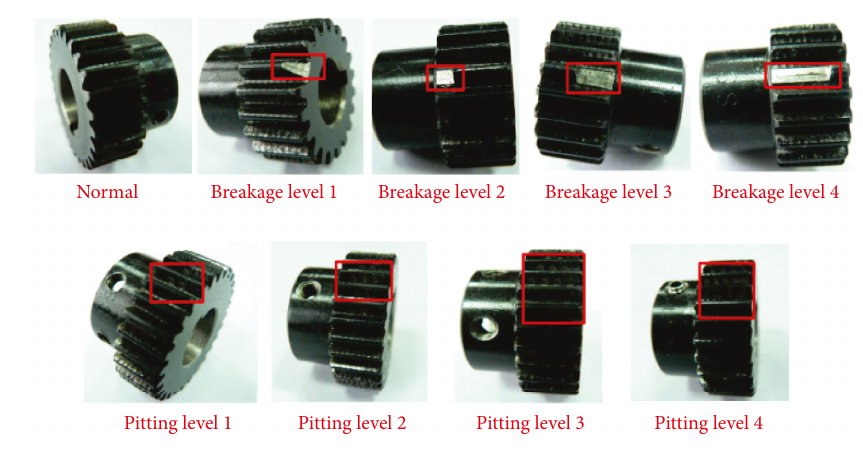
Figure 4: Normal planetary gear and different degradation states.